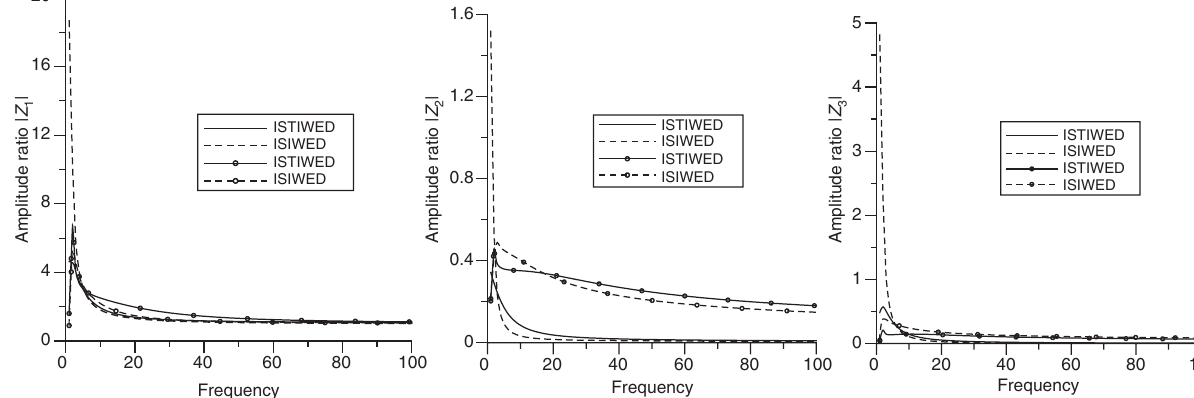
Figure 1 The variation of amplitude ratios of | Z